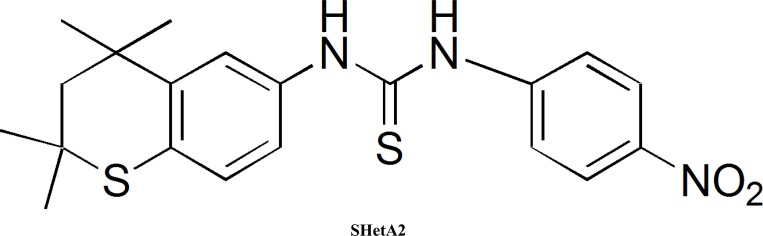
Chemical structure of SHetA2.